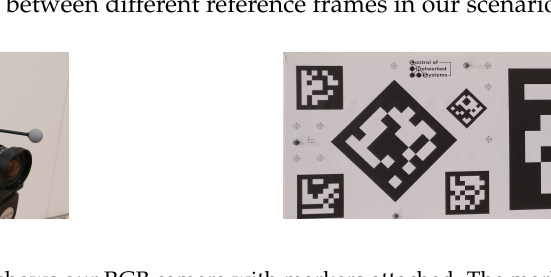
Figure 4. ( a ) shows our RGB camera with markers attached. The marker in the center of the marker constellation defines the position of the camera tracking body in the world frame. In ( b ) one can find the ArUco tag with OptiTrack markers on it used for extrinsic calibration of our camera. Best viewed as PDF and in